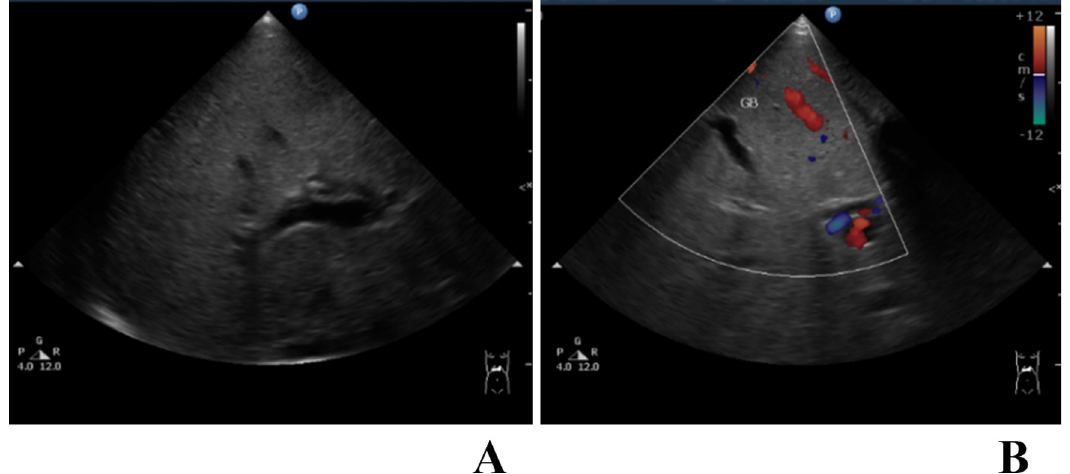
Fig 2. Examples of US images from a patient of BA. A. an US image in brightness mode. B. an US image with annotation in Doppler mode. GB: gallbladder.